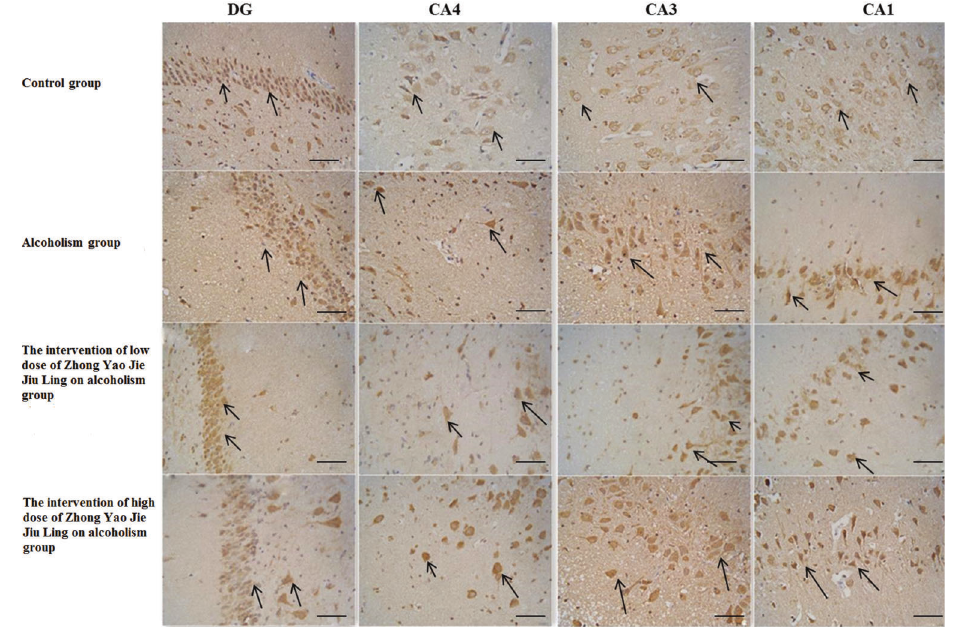
Figure 3. Tropomyosin receptor kinase B (TrkB)-positive neurons in the dentate gyrus (DG) and hippocampus (CA4, CA3, and CA1) in the four groups (bars: 100 m m). The arrows indicate TrkB-positive neurons.